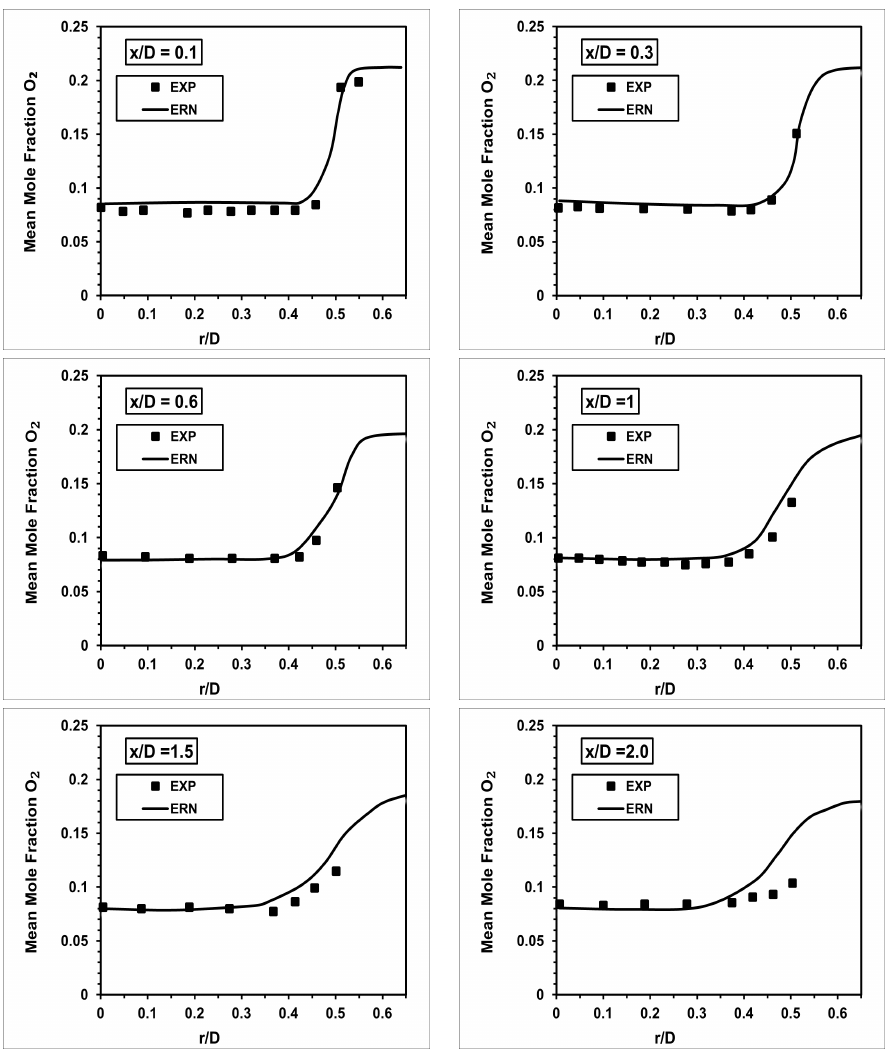
Figure 10. The computed O 2 mole fraction is compared to the experimental measurements at axial locations x / D : 0.1, 0.3, 0.6, 1, 1.5, and